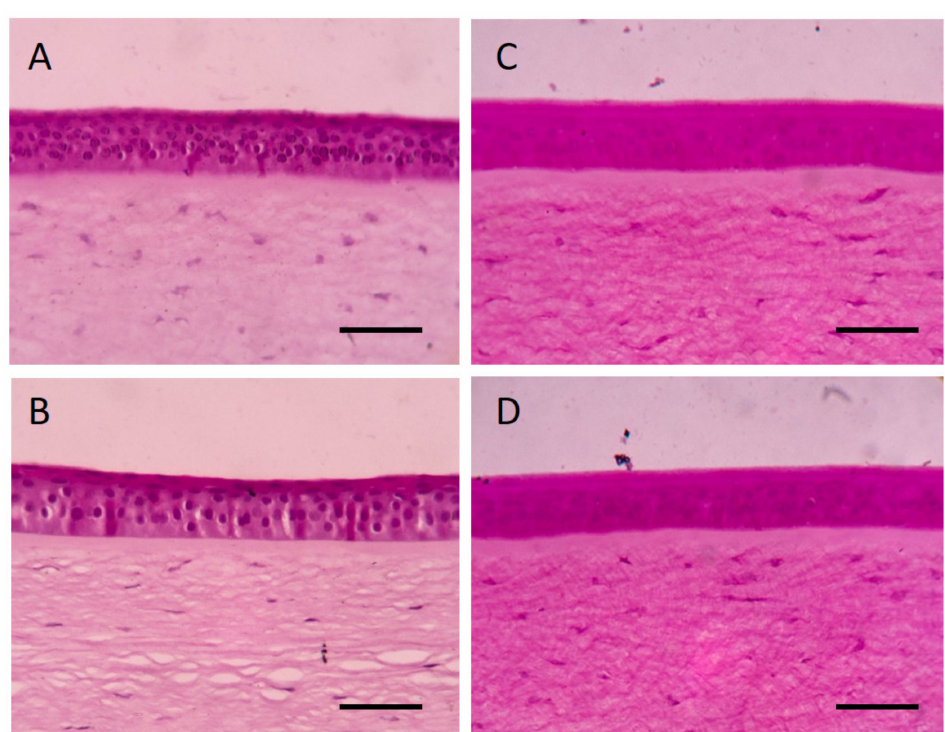
Figure 5. Histopathological findings of representative cross section from chicken corneas exposed to ( A , C ) negative control (0.9% NSS) and ( B , D ) Hydrogel of 10 µ g/mL PZQ for 21 days. The images are representative of three independent assays ( n = 3/chemical substance). Photomicrography with Hematoxylin and eosin (panels on the left-hand side) and Periodic Acid-Schiff staining (panels on the right-hand side) The scale bars represent 20